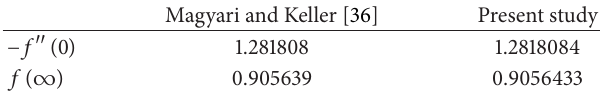
Table 1: The values of 𝑓 󸀠󸀠 (0) and 𝑓(∞) for 𝑎/𝑐 = 0